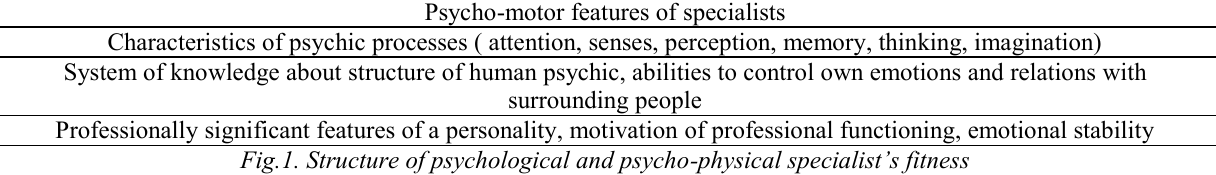
Fig.1. Structure of psychological and psycho-physical specialist’s